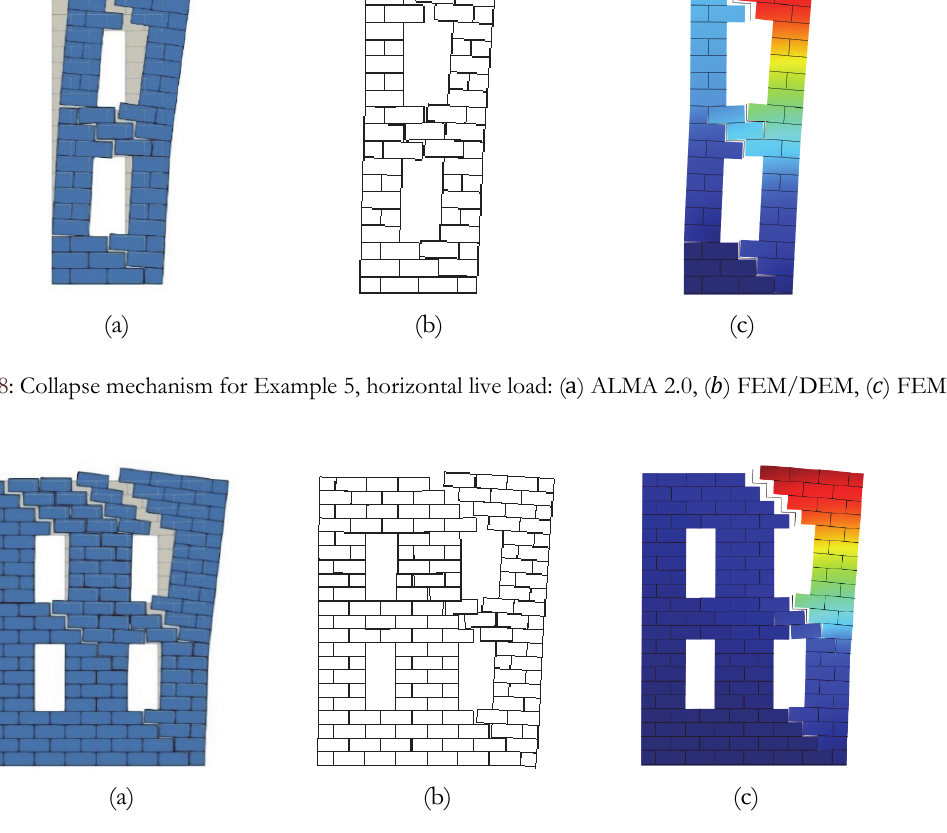
Figure 9: Collapse mechanism for Example 6, horizontal live load: ( a ) ALMA 2.0, ( 𝑏 ) FEM/DEM, ( 𝑐 )